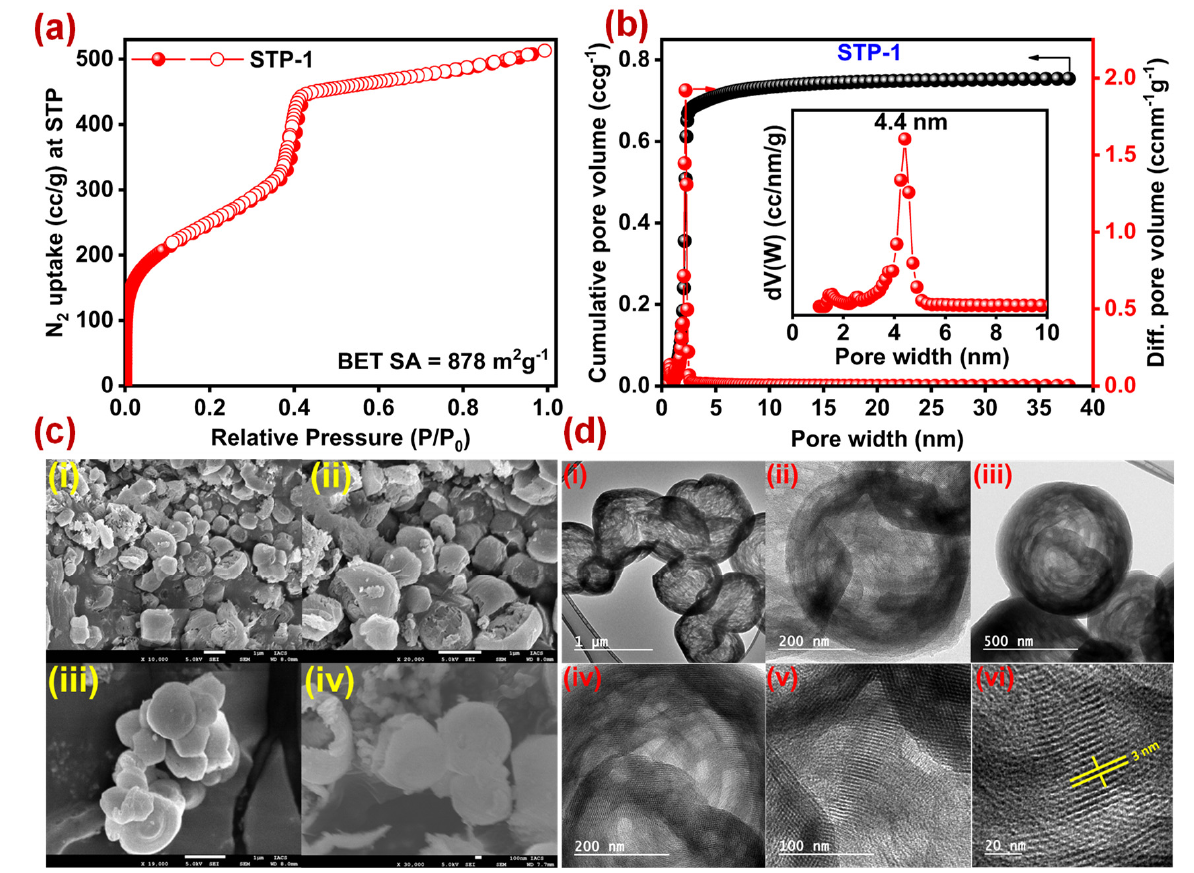
Figure 2. ( a ) N 2 sorption isotherm of STP − 1 at 77 K; ( b ) pore size distribution of STP − 1 by using the NLDFT method; ( c ) SEM images (i–iv) of STP − 1; ( d ) TEM images (i–vi) of STP − 1.